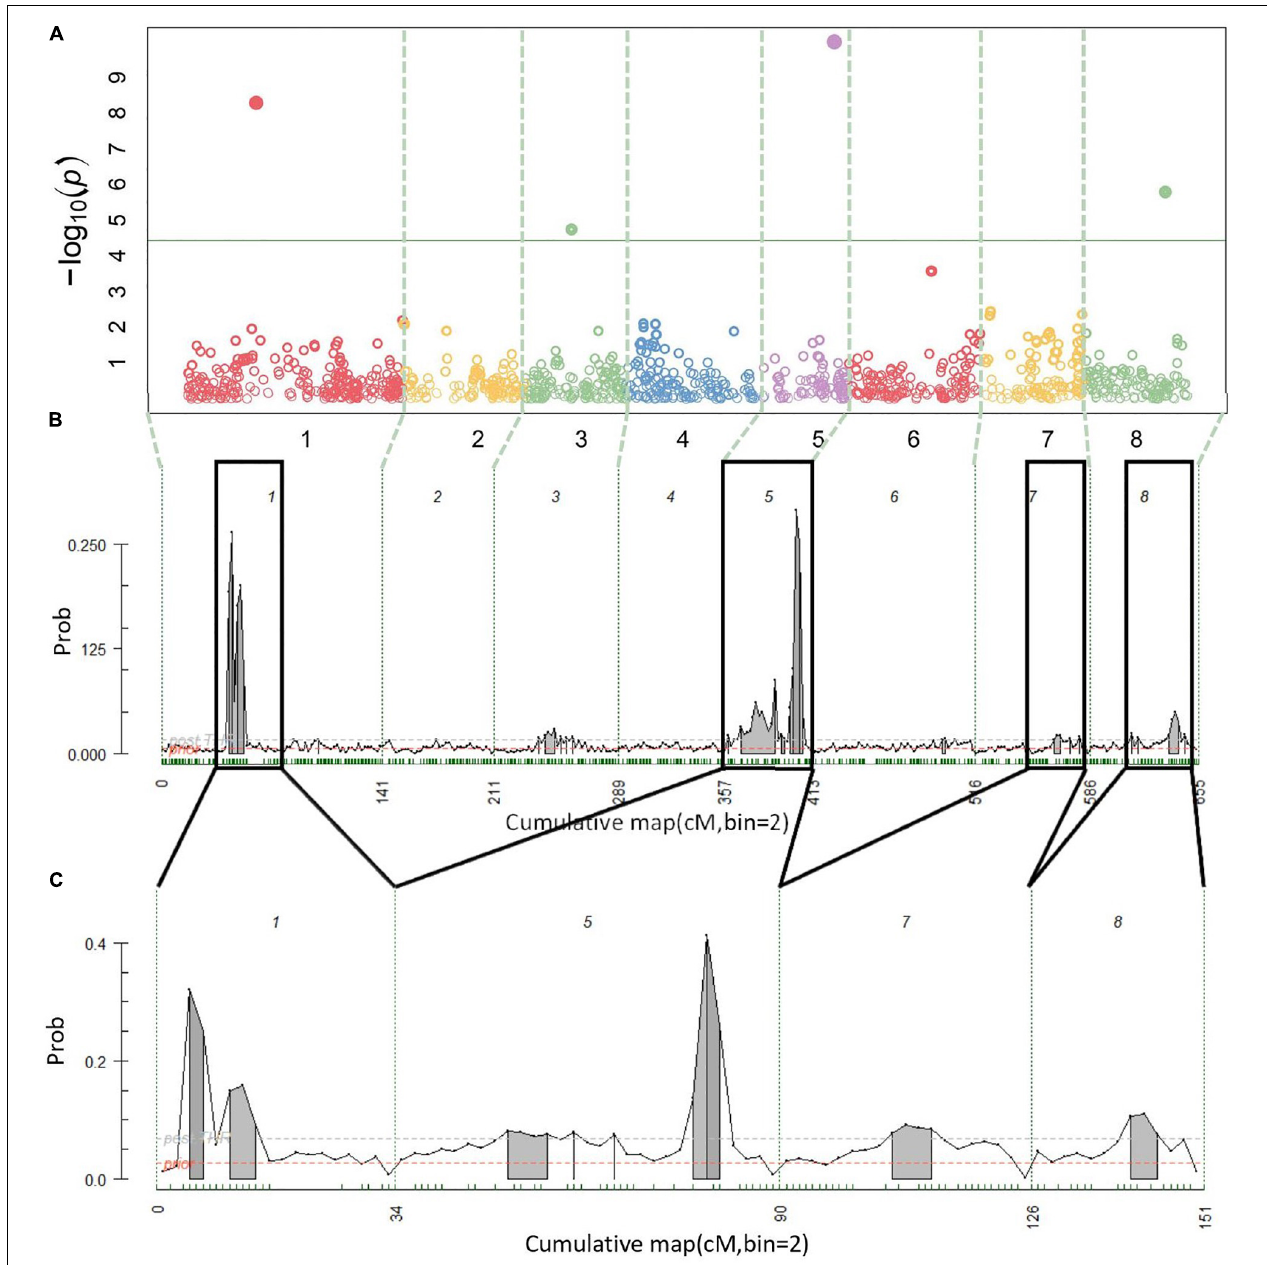
FIGURE 2 | Multiyear cracking incidence quantitative trait locus (QTL) detection results. Manhattan plot from BLINK (A) , posterior probabilities of QTL positions from FlexQTL TM full genetic map analysis (B) , and FlexQTL TM reduced map analysis (C) . Dashed vertical lines (A–C) demarcate the chromosomes. Colored circles in (A) represent individual single nucleotide polymorphisms (SNPs), their height corresponding to the degree of association between variation in SNP genotype and trait variation. The green horizontal line in (A) indicates a Bonferroni adjusted p -value of 0.05. Small green dashes along the horizontal axes in (B) and (C) indicate SNPs grouped in 2 cM bins. Peaks indicate evidence for a QTL at that genomic location, with an area filled in gray indicating positive QTL evidence. The dark black outlines in (B) indicate approximate intervals from the full genetic map used to create the reduced map in (C) . Results from both FlexQTL TM runs were achieved with an additive-only